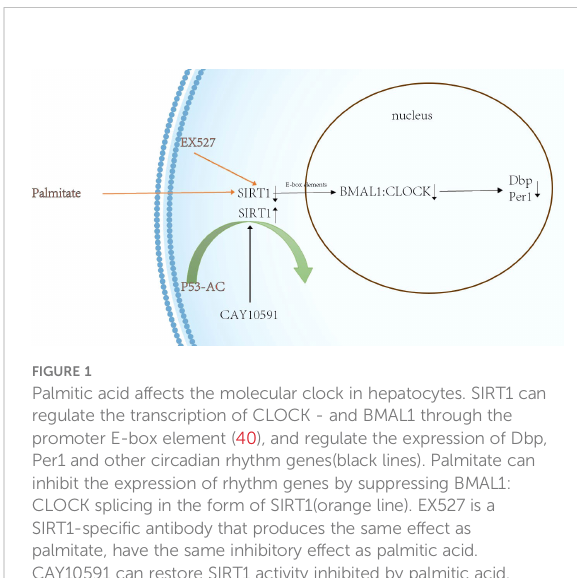
FIGURE 1 Palmitic acid affects the molecular clock in hepatocytes. SIRT1 can regulate the transcription of CLOCK - and BMAL1 through the promoter E-box element (40), and regulate the expression of Dbp, Per1 and other circadian rhythm genes(black lines). Palmitate can inhibit the expression of rhythm genes by suppressing BMAL1: CLOCK splicing in the form of SIRT1(orange line). EX527 is a SIRT1-speci fi c antibody that produces the same effect as palmitate, have the same inhibitory effect as palmitic acid. CAY10591 can restore SIRT1 activity inhibited by palmitic